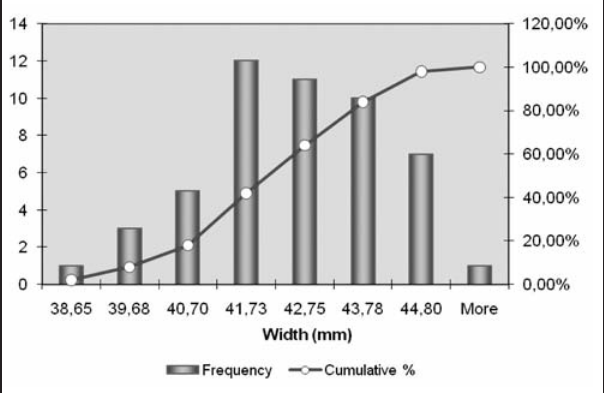
Fig. 37: Distribution of width values of category A of Late Jumbo apricot